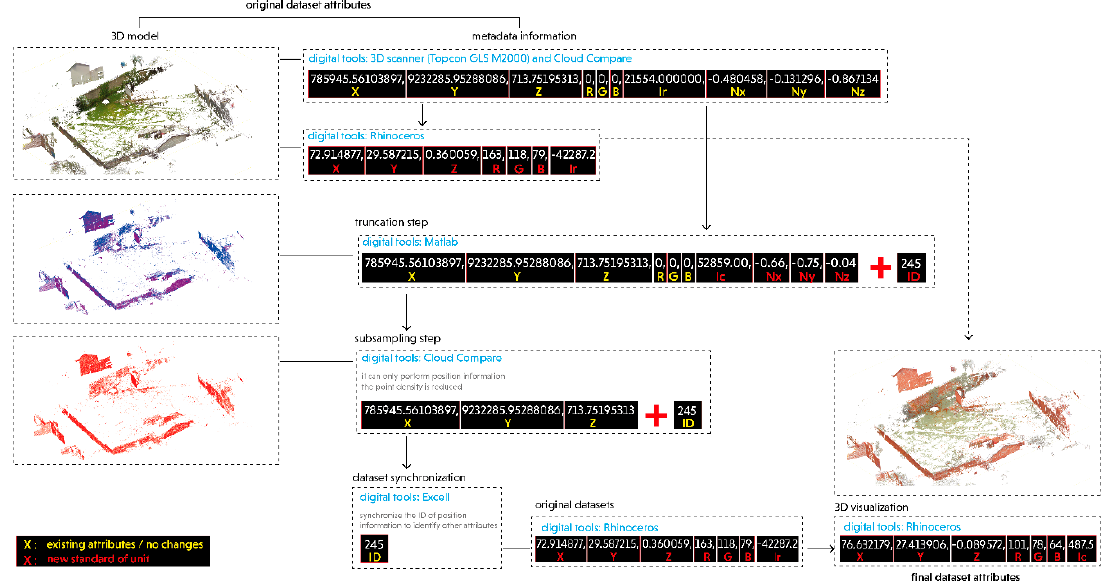
Figure 11. Transformation of the dataset attributes.